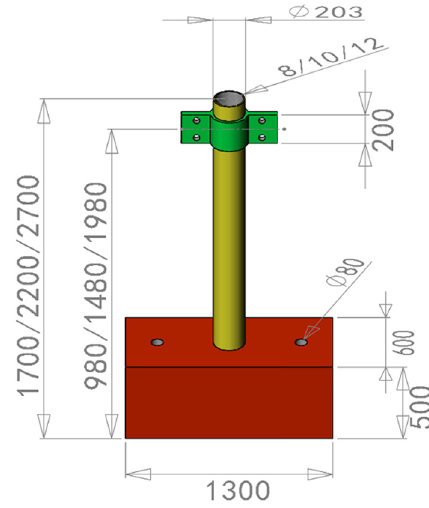
Figure 1: Schematic